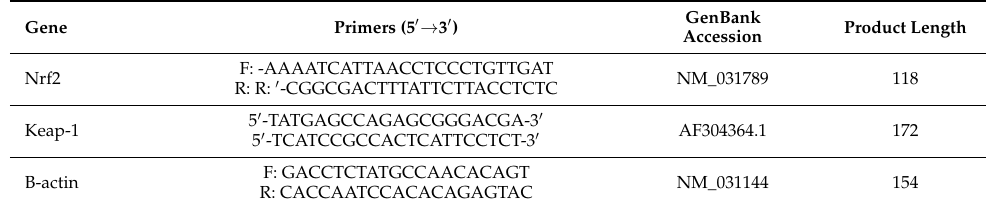
Table 1. Primer characteristics of the real-time PCR.